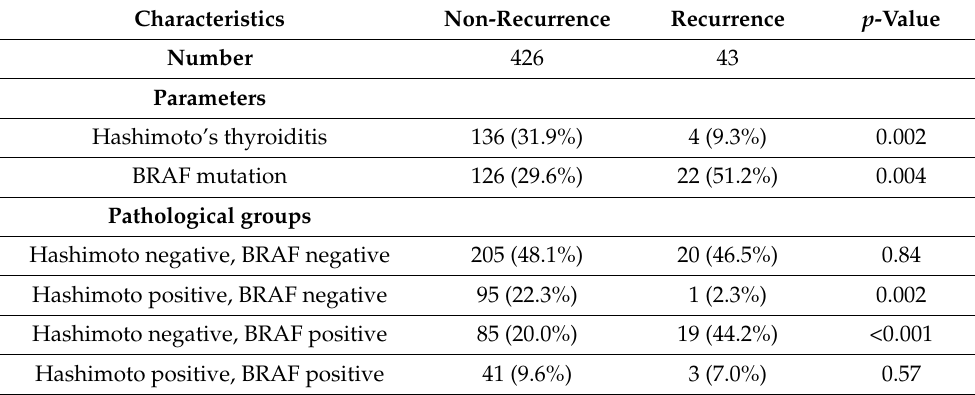
Table 2. Recurrence and non-recurrence in patients by Hashimoto’s thyroiditis and BRAF mutation. Percentage is reported per the designated group. Data are presented as number and percentage. Two-sided Chi-Square, Student’s t, and Mann–Whitney U tests were used.